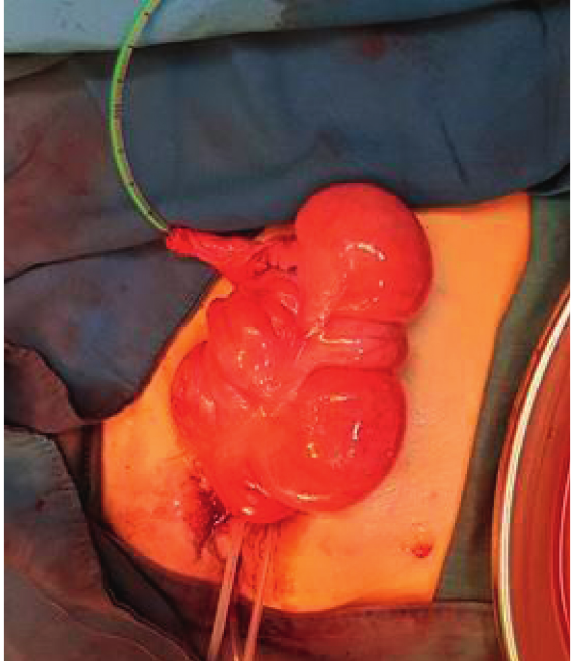
Figure 2: Normal saline passing through the conduit (appendix) after closing catheters of